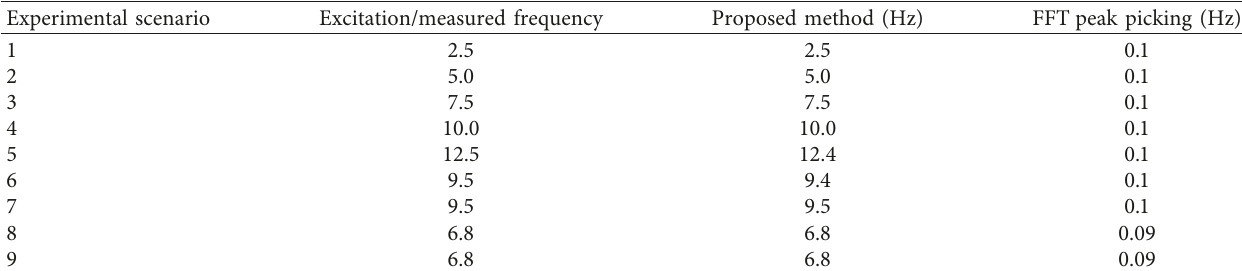
Figure 24: Simply supported carbon plate experimental case 2 result from the vibrometer. (a) Normalized acceleration signal. (b) Normalized power spectral density. Table 2: Summary of result